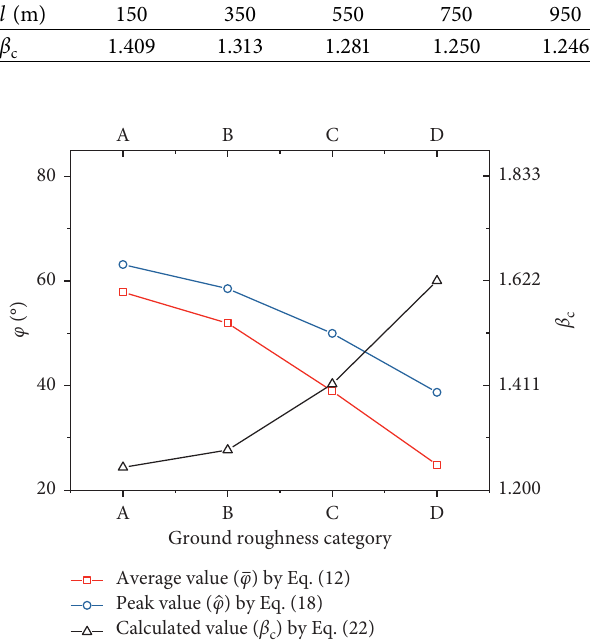
Figure 11: Influence of ground roughness category on the windage yaw angle ( φ